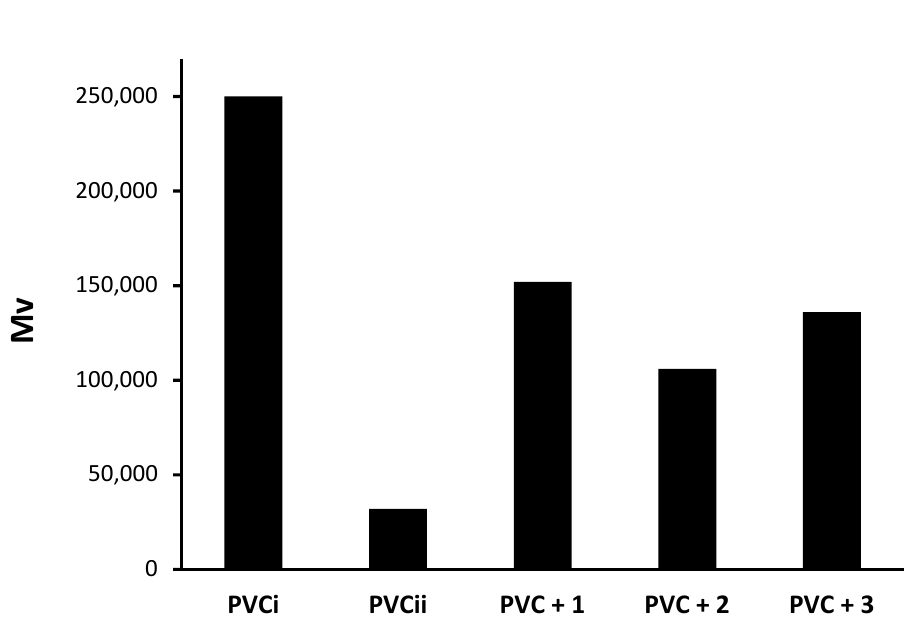
Figure 10. Molecular weight ( M V ) for PVC films decreases after irradiation. PVCi and PVCii represent Figure 10. Molecular weight ( 𝑀(cid:3365) (cid:2906) ) for PVC films decreases after irradiation. PVCi and PVCii the M V of PVC before and after irradiation (300 h), respectively. Figure 10. Molecular weight ( 𝑀(cid:3365) (cid:2906) ) for PVC films decreases after irradiation. PVCi and PVCii represent the 𝑀(cid:3365) (cid:2906) of PVC before and after irradiation (300 h), respectively. represent the 𝑀(cid:3365) (cid:2906) of PVC before and after irradiation (300 h), respectively.